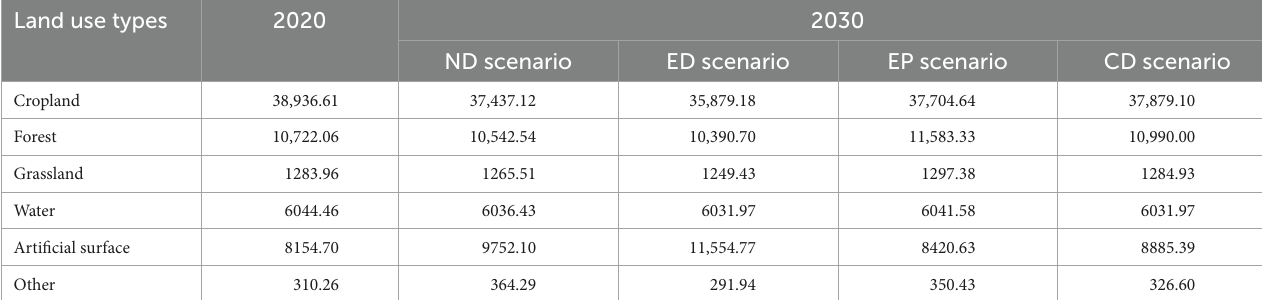
TABLE 3 LULC area for four scenarios (km 2